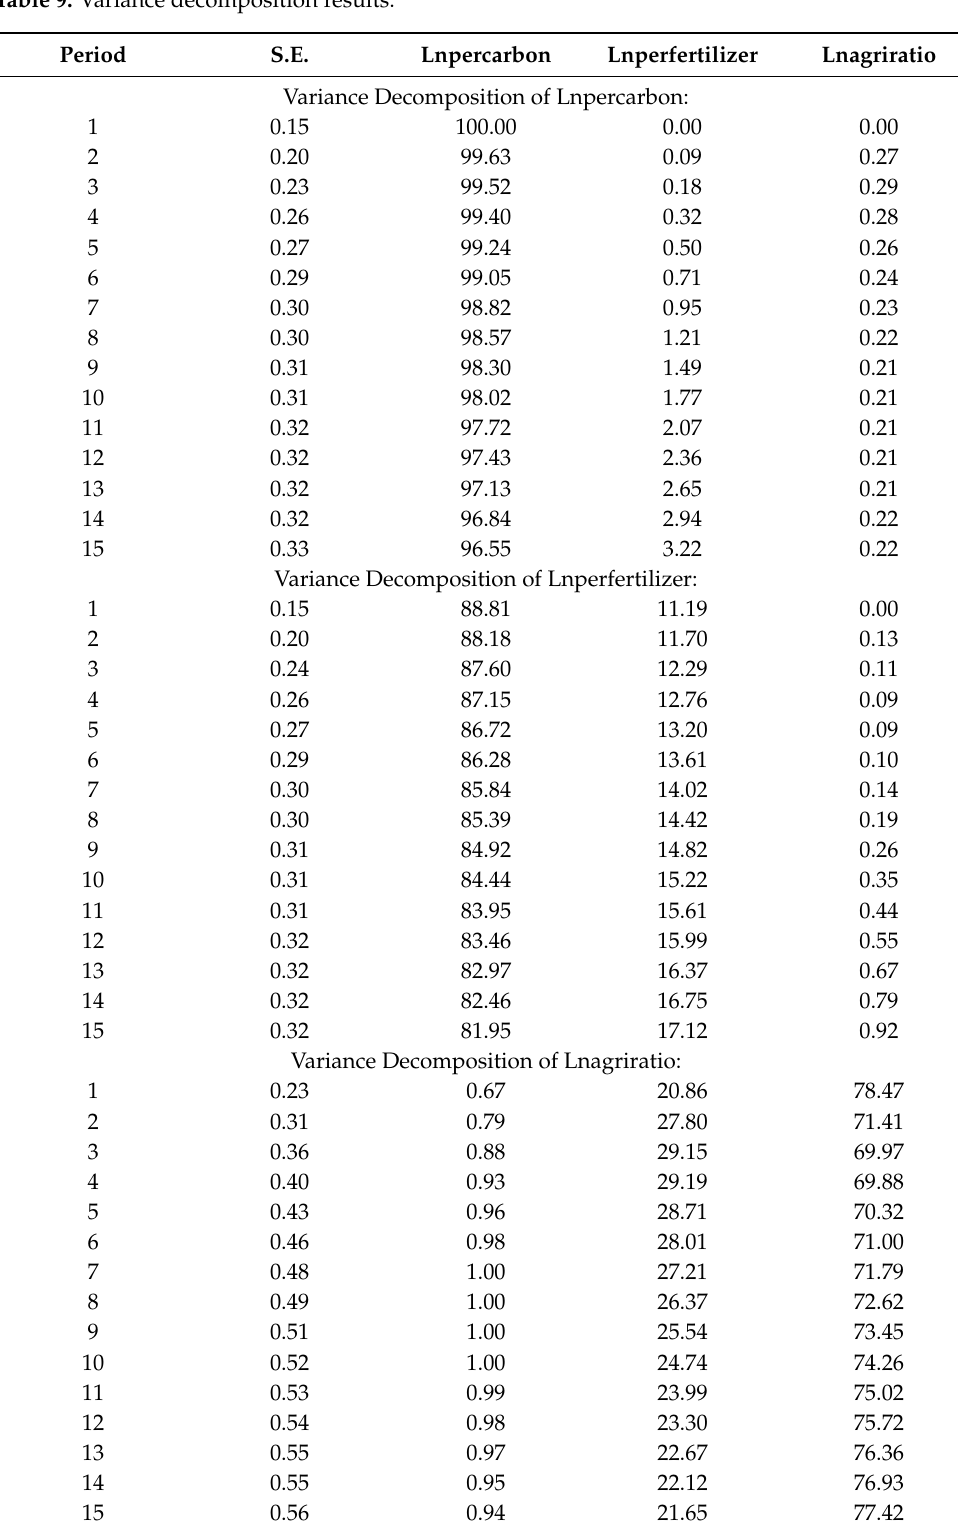
Table 9. Variance decomposition